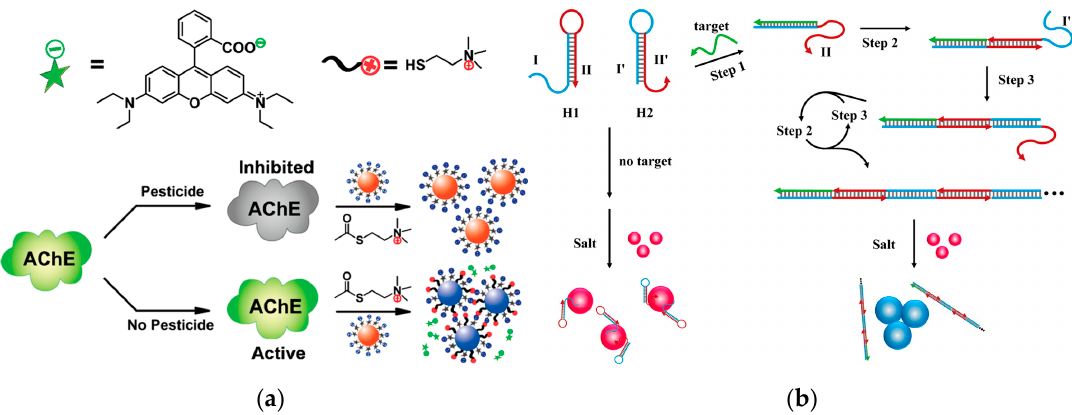
Figure 8. Visual biosensor based on AuNPs. ( a ) Dual-readout assay based on AuNPs for pesticides. Reproduced with permission from [120]. Copyright Analytical Chemistry, 2012. ( b ) Colorimetric detection of DNA by the use of AuNPs and hybridization chain reaction amplification. Reproduced with permission from [121]. Copyright Analytical chemistry,